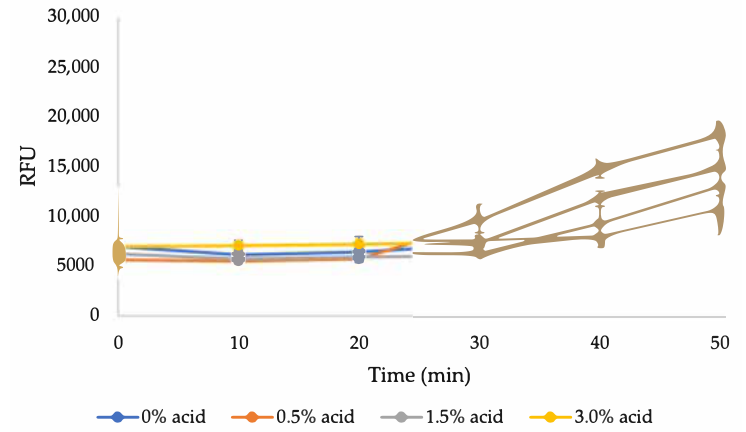
Figure A2. Kinetic fluorescence control test; varying concentrations of sulfuric acid, 0.4% KOH (pH = 13), 0.1% CFW.